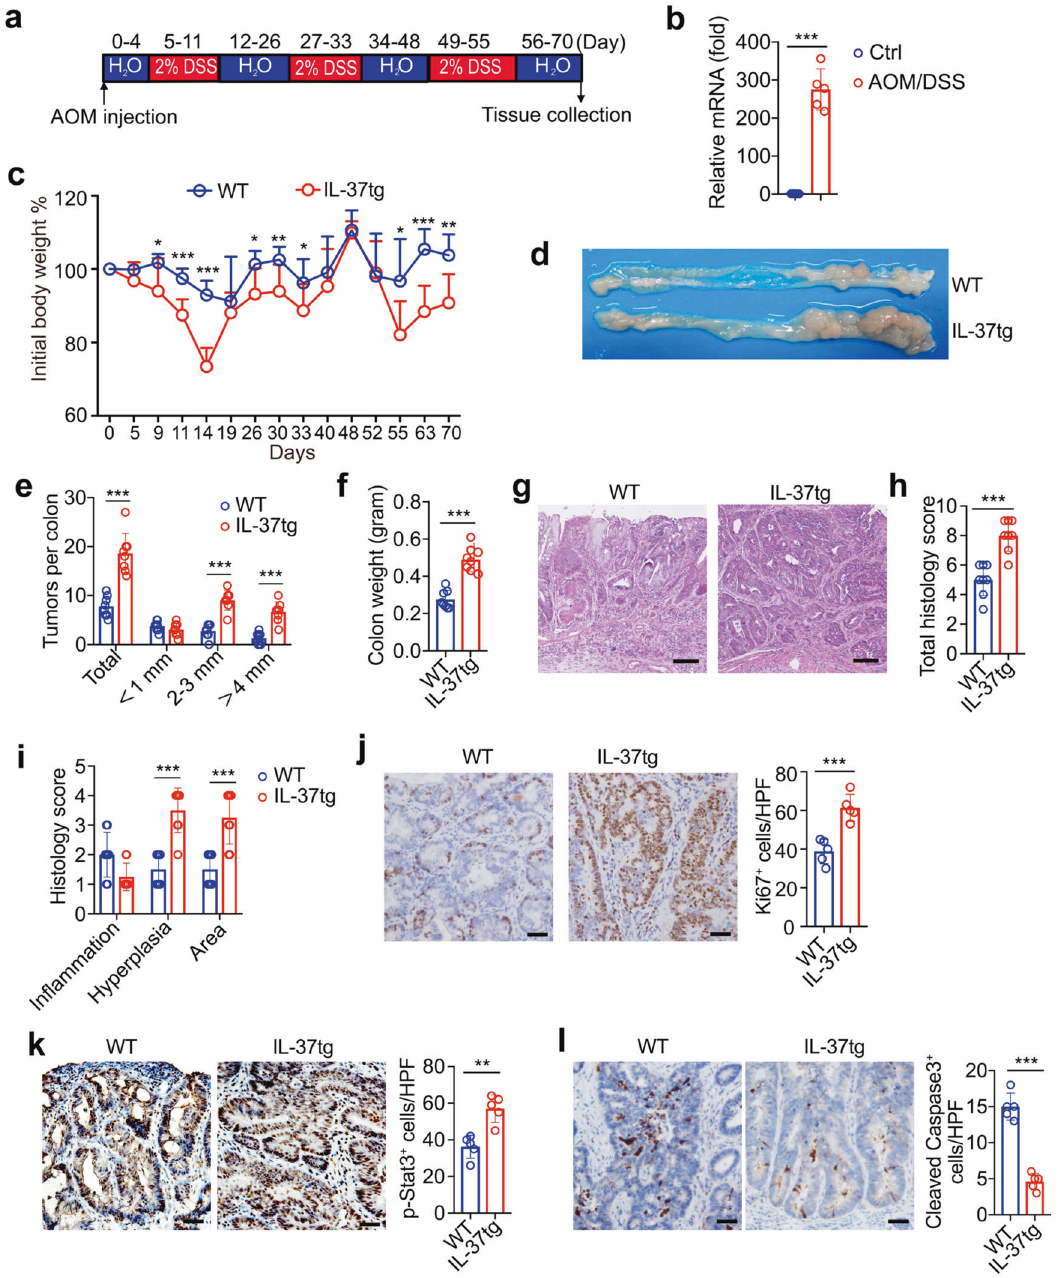
Fig. 2 Enhanced tumorigenesis in IL-37tg mice. a Details of the azoxymethane/dextran sodium sulfate (AOM/DSS) treatment used for the induction of in fl ammation-associated colorectal cancer. IL37tg mice and WT mice were injected with AOM on day 0, and were then given a 2% DSS solution during three 6-day cycles as described in experimental procedures. b qRT-PCR analysis of IL-37 expression in the colon of IL-37tg mice after treatment with or without AOM/DSS, n = 5/group. c The body weight loss of IL-37tg mice and WT mice following injected with AOM on day 0 and administered 3 rounds of 2% DSS in drinking water, n = 8/group. d Representative image of the distal colon at day 70 after AOM/DSS administration, tumor development in the colon was determined. e Quanti fi cation of the number of tumors in the colon at day 70 after AOM/DSS administration, n = 8/group. f Colon weight was determined in IL-37tg mice and WT mice at day 70 after AOM/DSS administration, n = 8/group. g Colon tissue sections of IL-37tg mice and WT mice by H&E staining at day 70 after AOM/DSS administration. Scale bar, 100 μ m. h , i Total histological scores ( h ) and scores for different parameters ( i ) of IL-37tg mice and WT mice at day 70 after AOM/DSS administration, n = 8/group. j – l Representative Ki67 ( j ), p-Stat3 ( k ), Cleaved Caspase3 ( l ) immunohistochemistry of colon in IL-37tg mice and WT mice at day 70 after AOM/DSS administration, scale bars: 100 μ m. Positive cells were quanti fi ed by counting the stained dots, n = 8/group. All data are presented as mean ± SD. Statistics analyzed by Two-tailed Student ’ s T -test. * P < 0.05; ** P < 0.01; *** P < 0.001 LV-IL-37/LoVo cells and LV-Ctrl/LoVo cells (Supplementary Fig. analysis of the percentage of G1, S and G2 cells, and percentage of S4d). Injecting LV-IL-37/LoVo cells and LV-Ctrl/LoVo cells subcuta- apoptotic cells, suggested that IL-37 did not disturb the cell cycle neously into nude mice. Overexpression of IL-37 failed to change and apoptosis in Lovo cells (Supplementary Fig. S4b, c). Moreover, tumor volumes and weights compared to those in controls. the wound healing assay showed similar migratory ability of Signal Transduction and Targeted Therapy (2022)